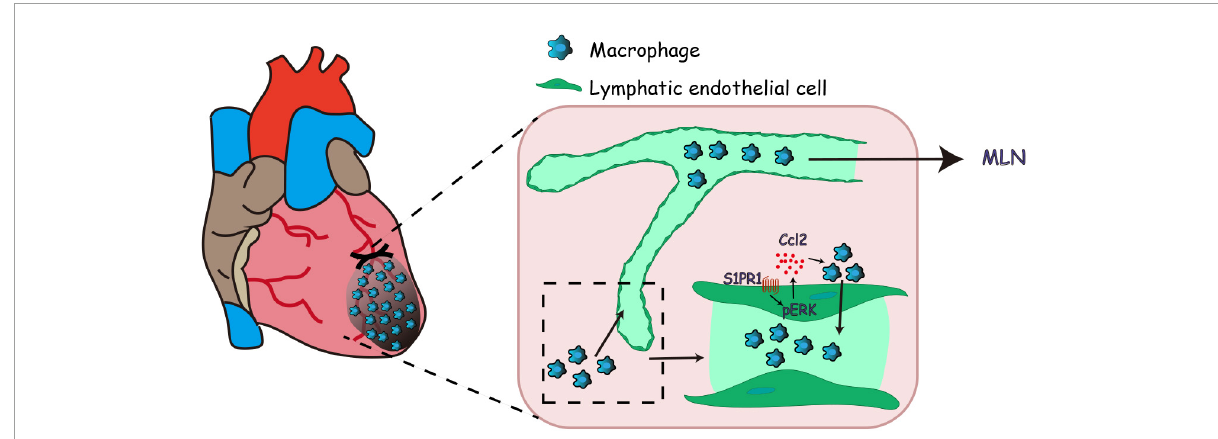
FIGURE7 Working model of lymphatic endothelial S1pr1 enhances macrophage clearance via lymphatic system following myocardial infarction.